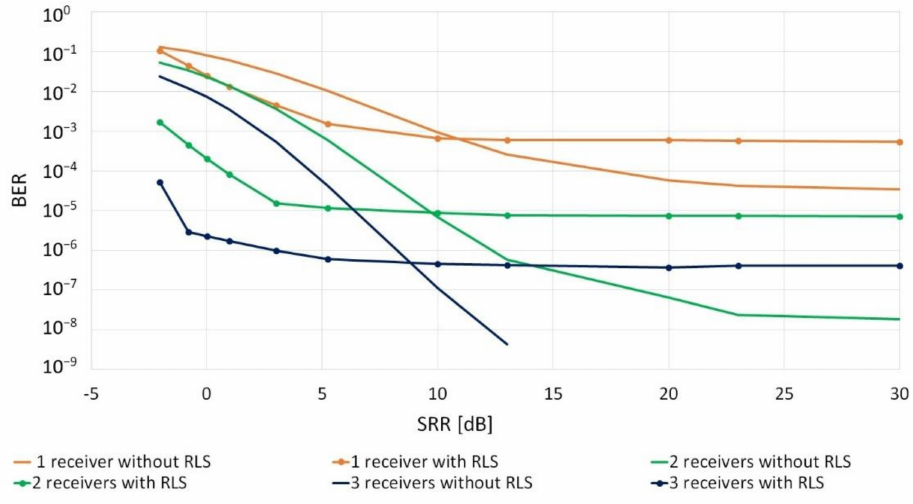
Figure 8. Influence of the total power of the replicas on the reception quality for SNR = 10 dB, the number of replicas =